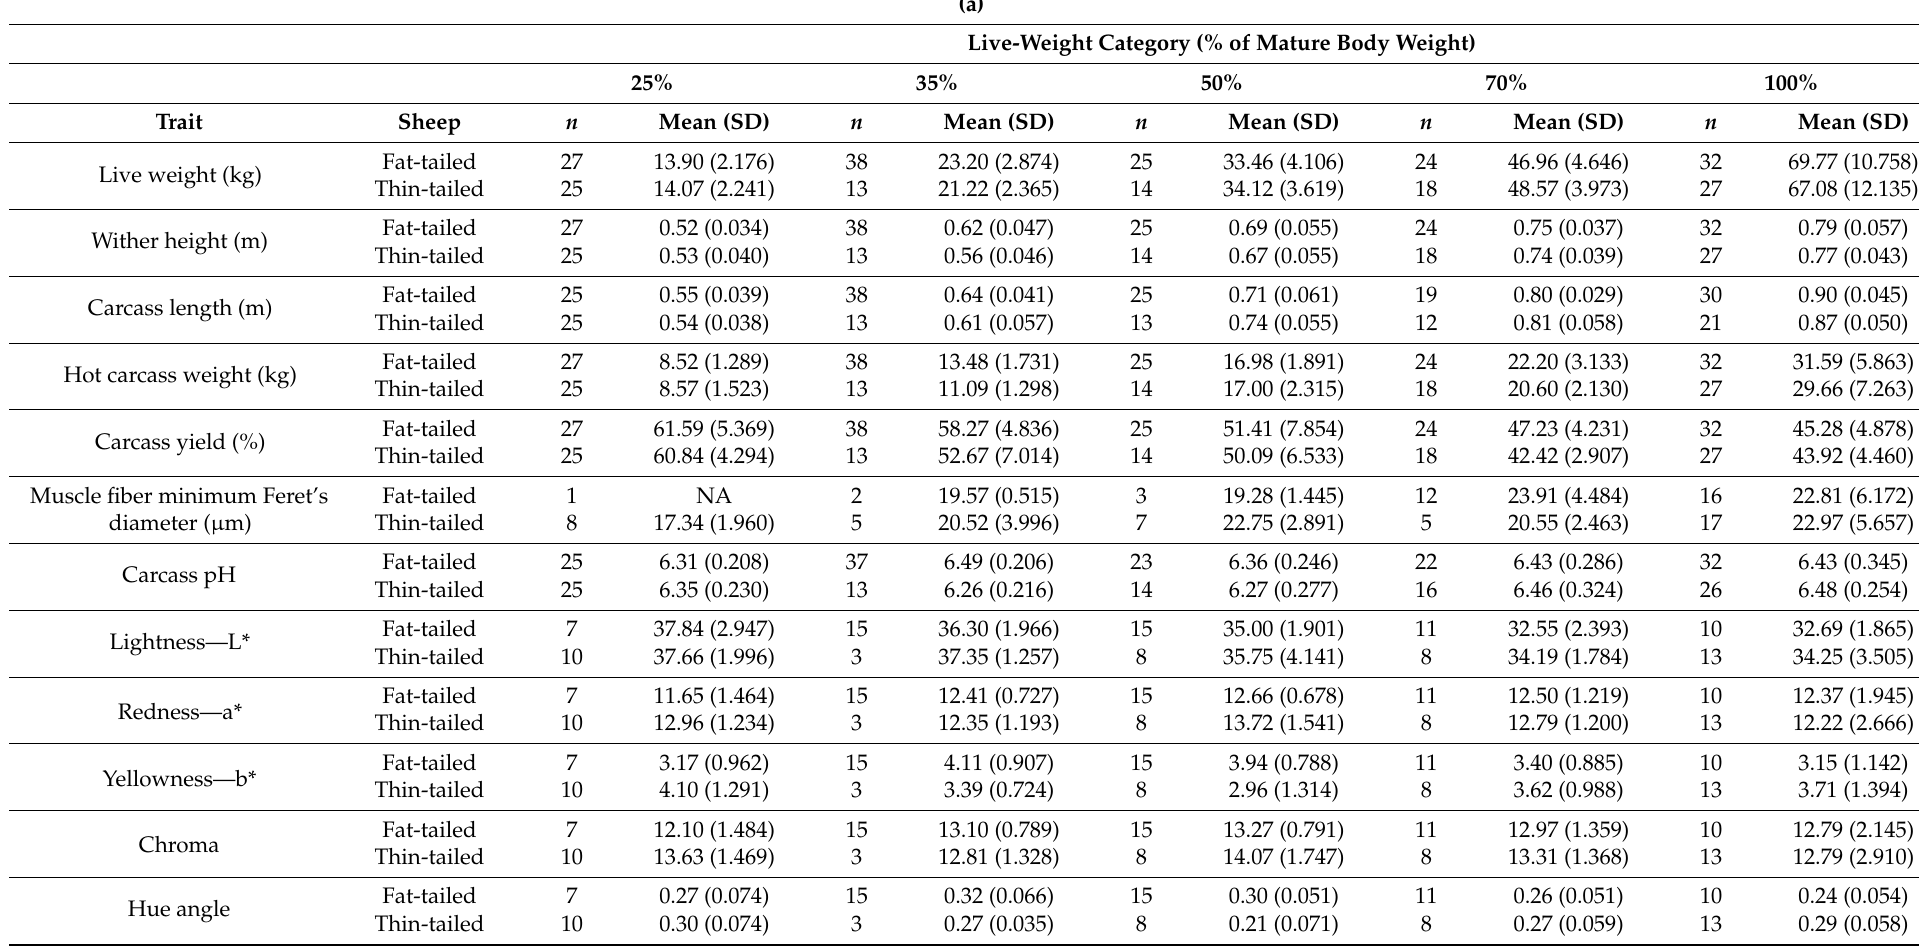
Table 2. ( a ) . Descriptive statistics for body, carcass and meat quality traits of fat-tailed and thin-tailed sheep per live-weight category (LWC). ( b ) Descriptive statistics for body, carcass and meat quality traits of fat-tailed and thin-tailed sheep per